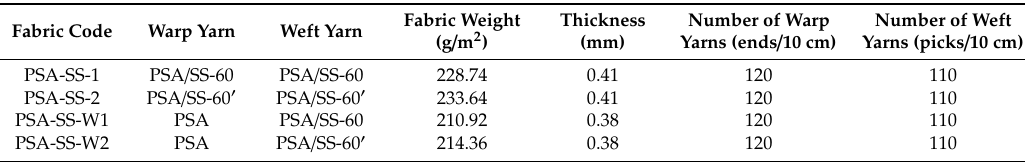
Table 1. The characteristics of conductive woven fabrics.